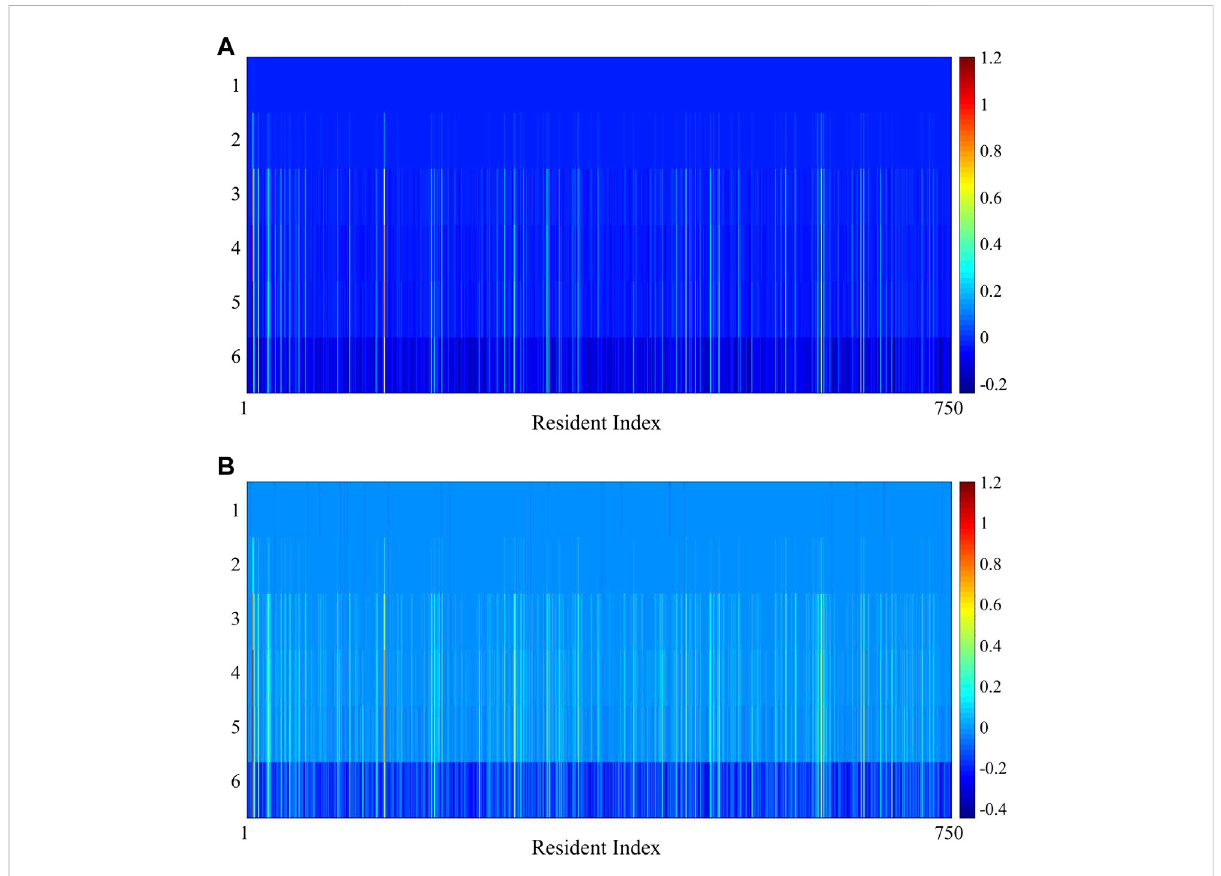
FIGURE 5 Effect of parameter η on the forecasting performance of the proposed method: 1) η = 1.0 × 10 − 5 , 2) η = 1.0 × 10 − 4 , 3) η = 1.0 × 10 − 3 , 4) η = 1.0 × 10 − 2 , 5) η = 1.0 × 10 − 1 , 6) η = 1.0×10 0 . (A) MAE reduction. (B) RMSE reduction.